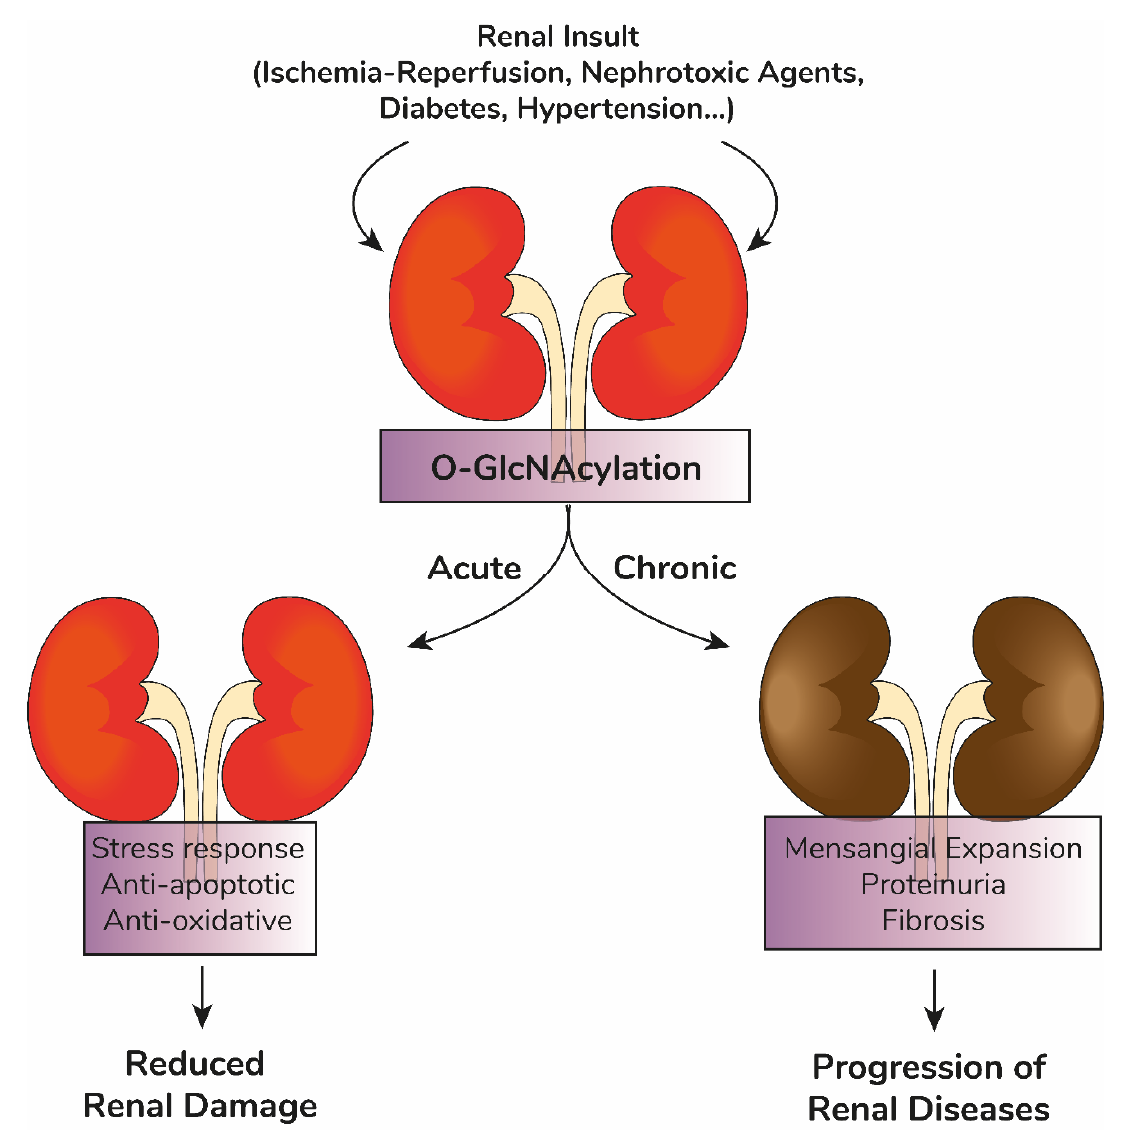
Figure 2. Proposed model. The kidneys are possible targets of acute (ischemia-reperfusion injury, nephrotoxic agents) or chronic (diabetes, hypertension) insults. Renal O-GlcNacylation is associated with different outcomes in these conditions: acute increases in O-GlcNAcylation are associated with stress response, decreased apoptosis, and oxidative stress, reducing renal damage; chronic increases in renal O-GlcNAcylation observed in diabetes and hypertension are associated with mesangial expansion, proteinuria, and renal fibrosis, inducing the progression of renal